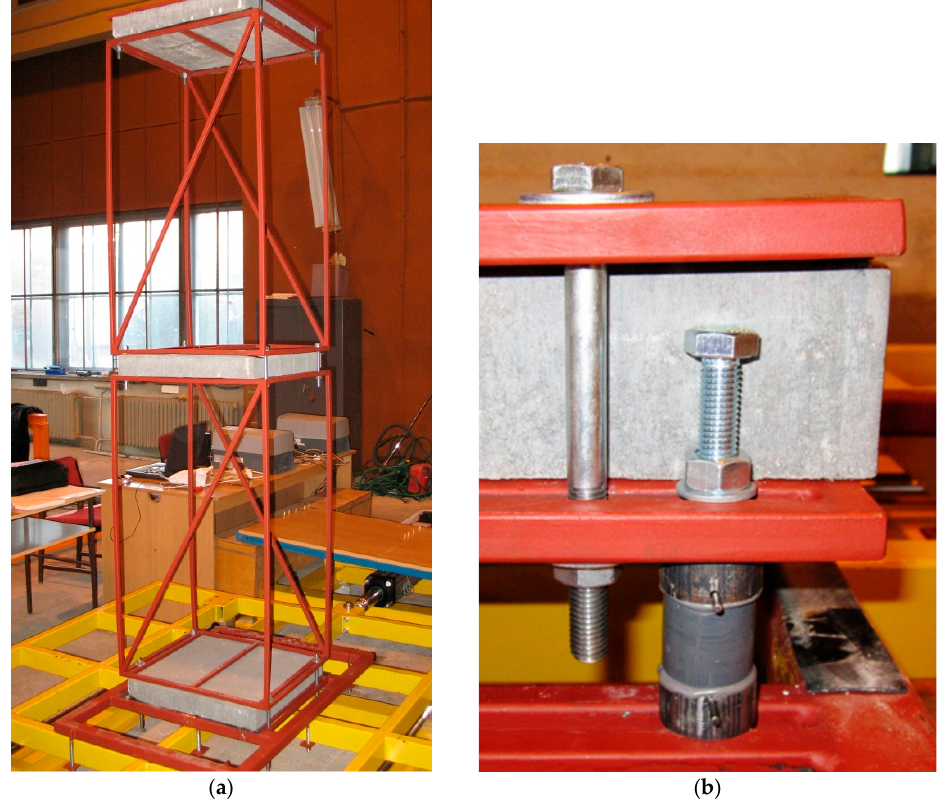
Figure 1. Shaking table investigation: fixed-base two storey experimental model ( a ) close-up view of PB used in base-isolated model ( b ).